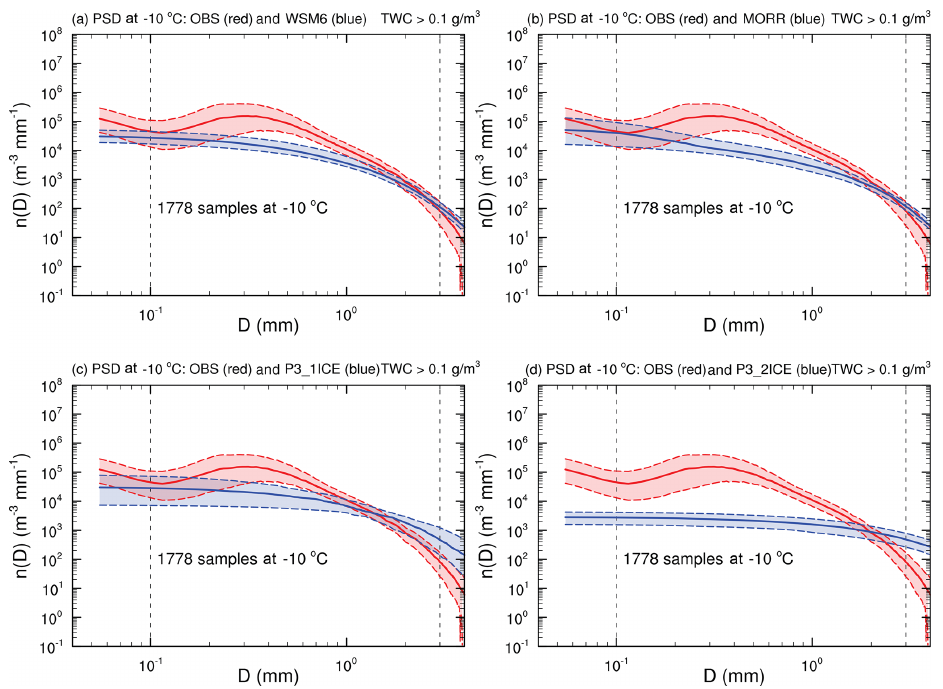
Figure 10. Observed (red) and simulated (blue, a : WSM6, b : MORR, c : P3-1ICE, d : P3-2ICE) ice particle size distributions at the level of − 10 ◦ C. The red and blue dashed lines indicate the 25th and 75th percentiles, and the red and blue solid lines represent the